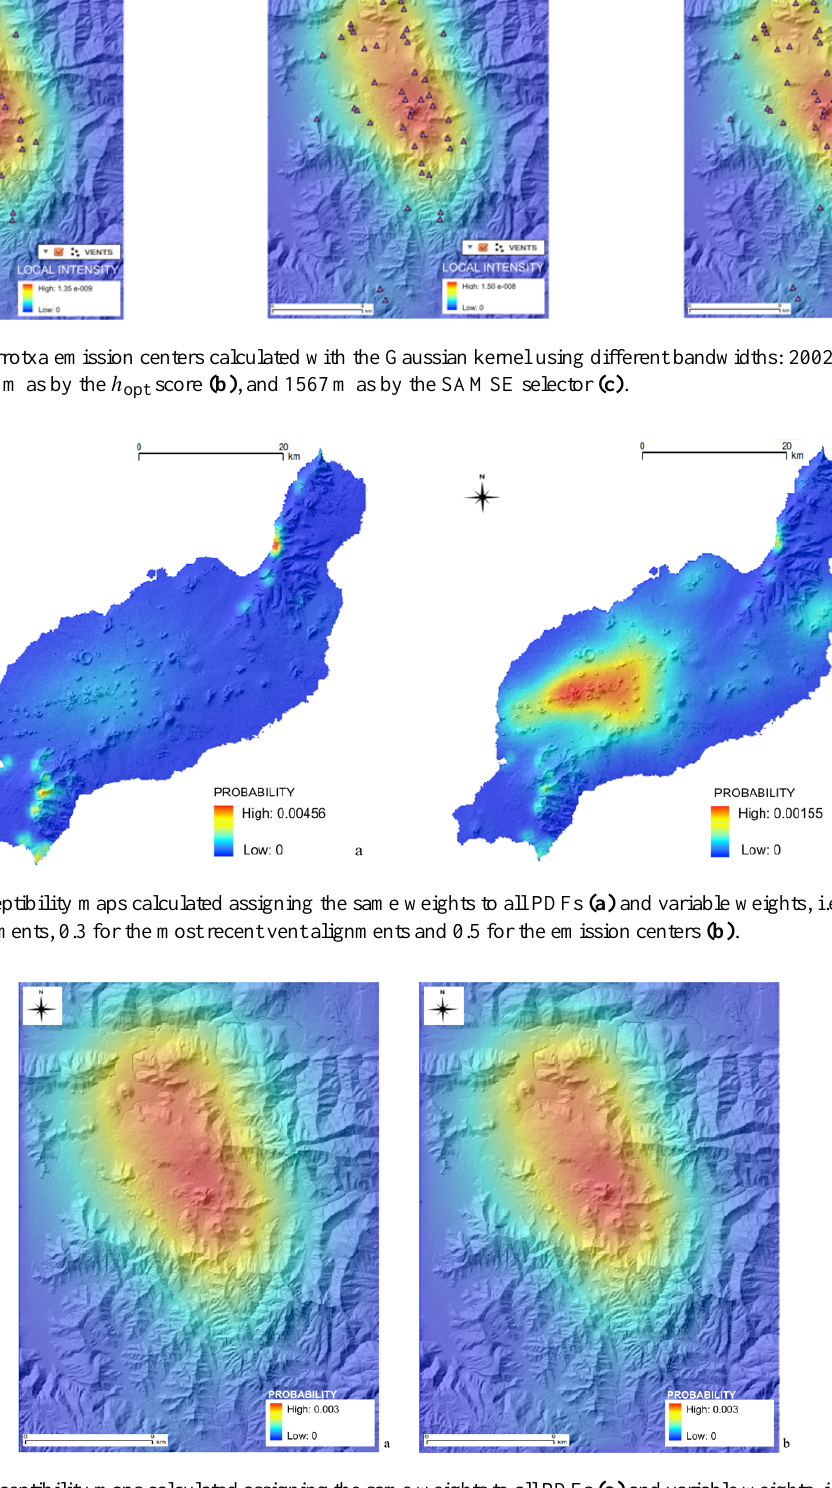
Fig. 13. La Garrotxa susceptibility maps calculated assigning the same weights to all PDFs (a) and variable weights, i.e., 0.03 for alignments and 0.7 for the emission centers (b)